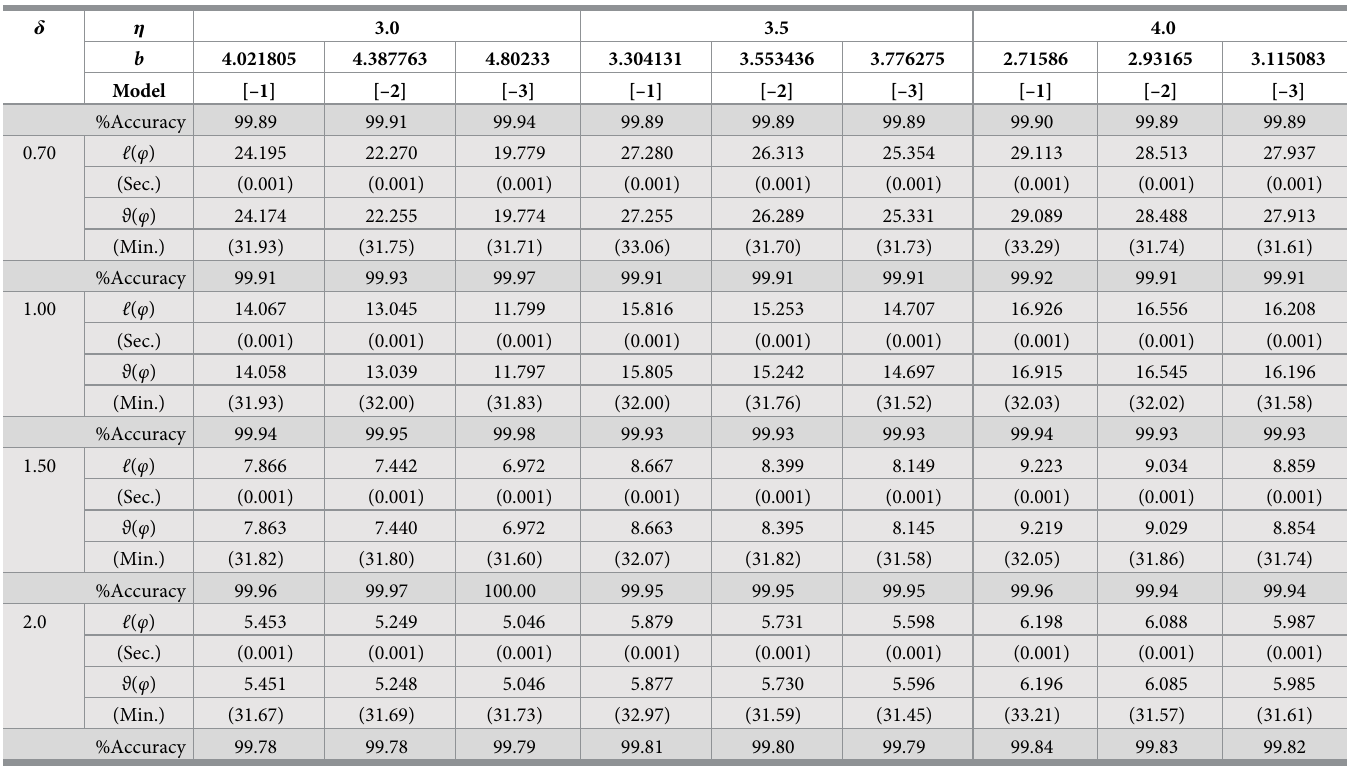
processes with expo- s